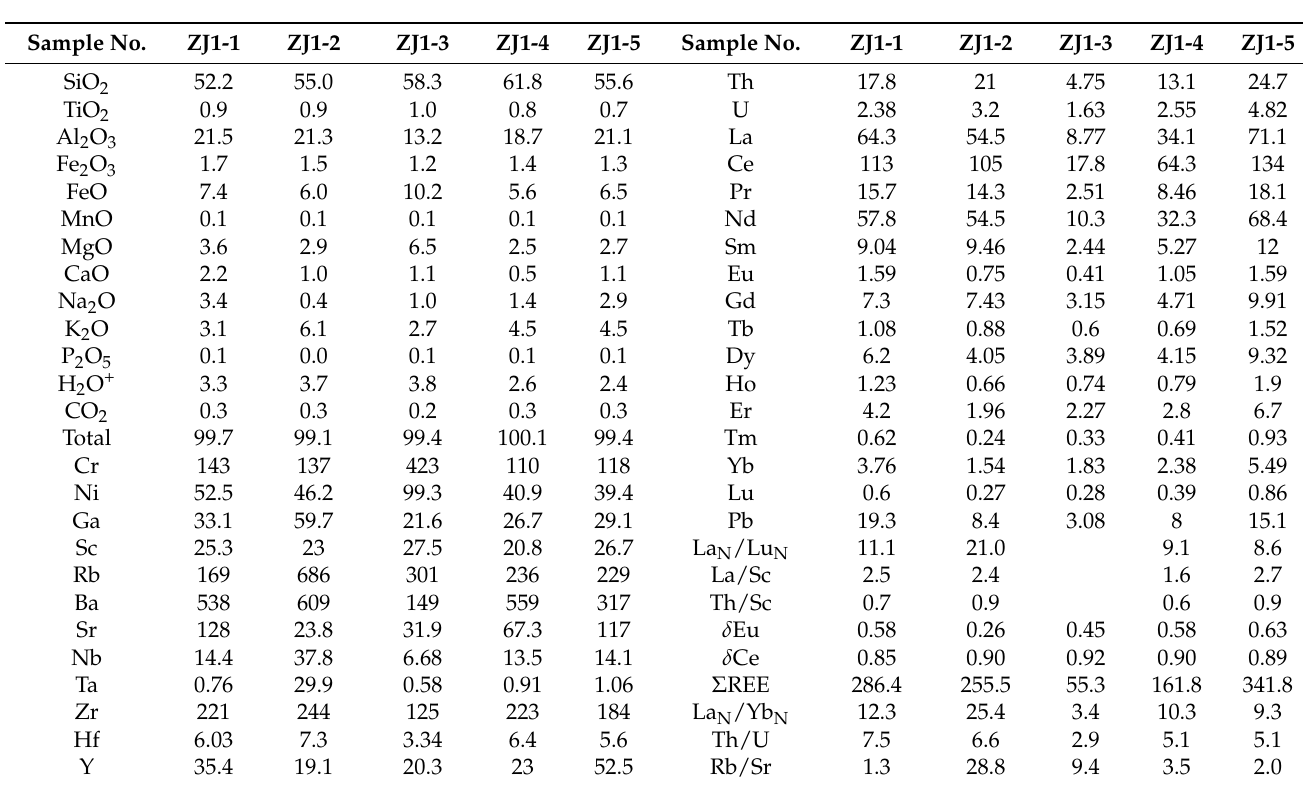
Table 3. Major and trace element contents of whole-rock sample from the northeastern Ordos Basin basement.